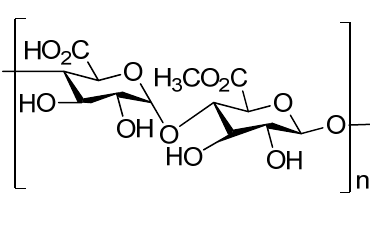
Figure 2. Chemical structure of pectin.